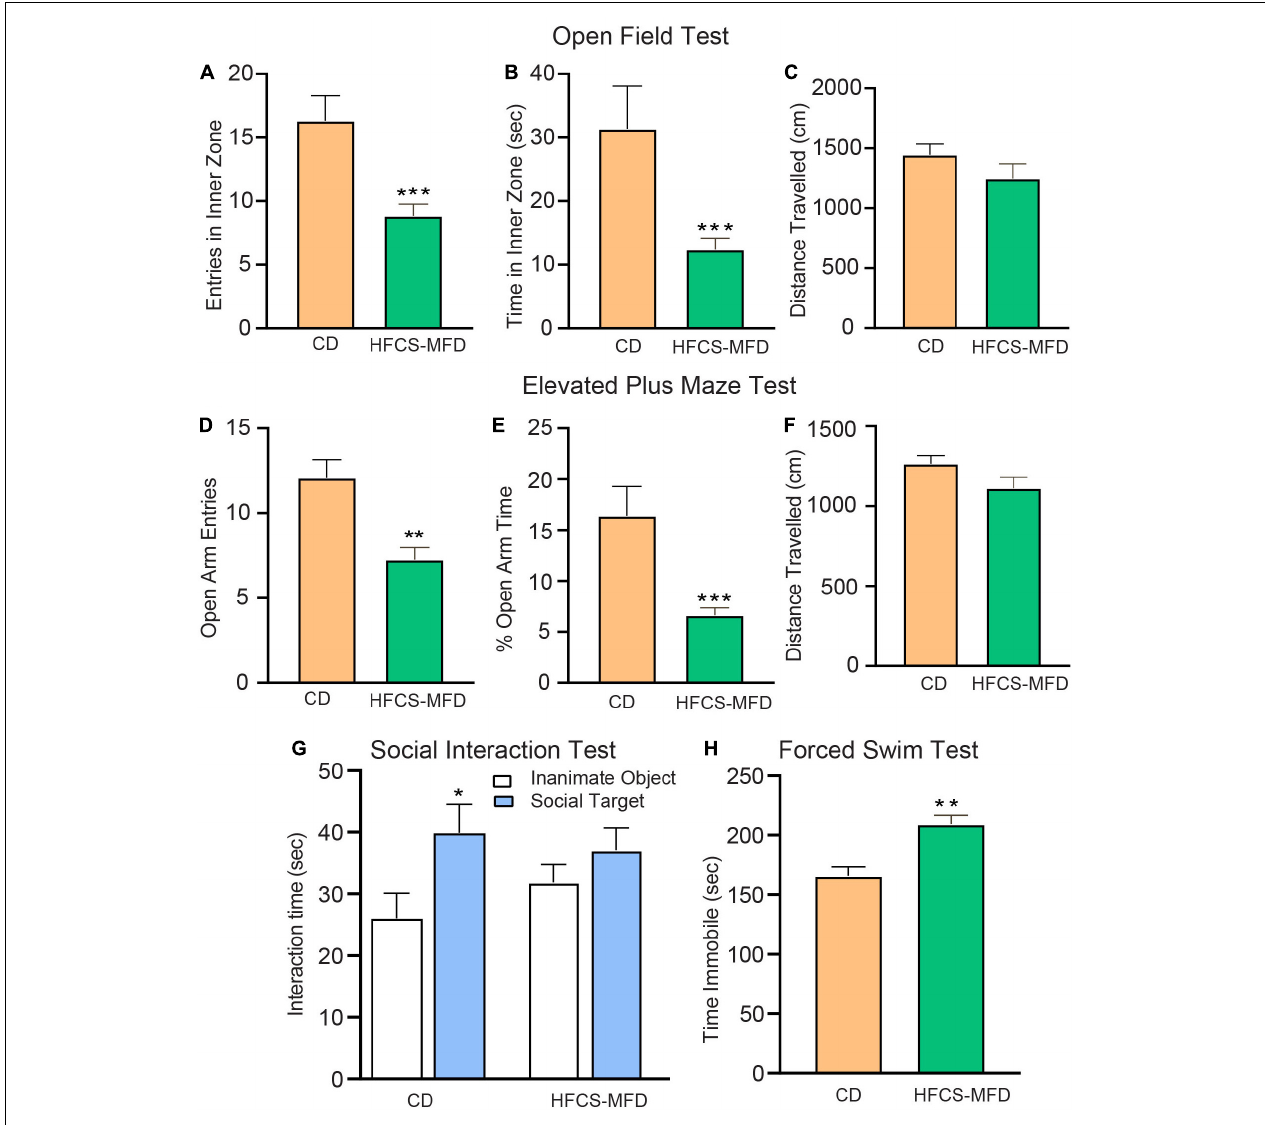
FIGURE 2 | HFCS-MFD consumption potentiates anxio-depressive behavior. The effects of HFCS-MFD vs CD on (A) Entries in the inner zone (B) Time spent in the inner zone and (C) Distance travelled for 5 min exploration in the Open field test. (D) Number of open arm entries (E) Percent Time spent in the open arms and (F) Distance travelled for 5 min exploration in the elevated plus maze test (G) Interaction time with a social target (stranger mice) versus an inanimate object (empty cylinder) during 10 min exploration in the three chambered social interaction test (H) Immobility time in the last 5 min of Forced swim test ( n = 10-12 per group; * p < 0.05 ** p < 0.01 *** p < 0.001 unpaired t